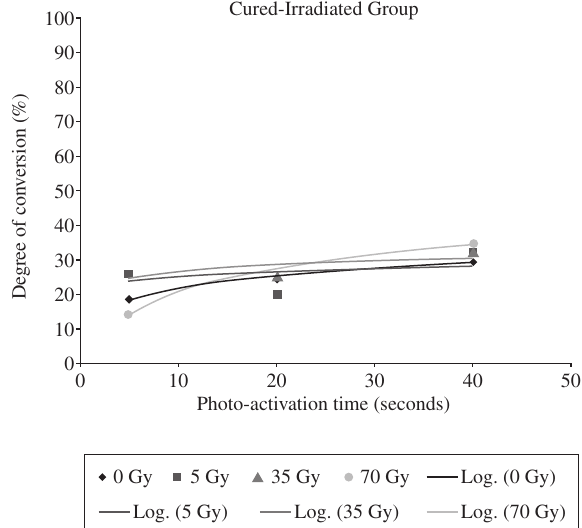
Figure 7. Regression analysis of degree of conversion of the Fill Magic Flow ® material to uncured-irradiated groups in accordance with radiation dose as a function of the photo-activation time.